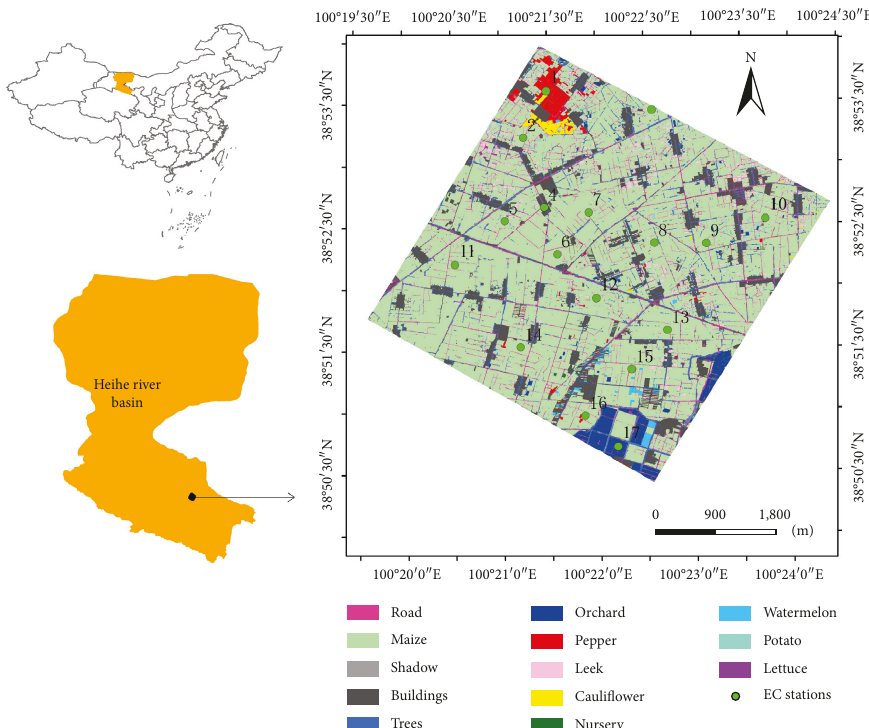
Figure 4: Location of the study area with land use types and 17